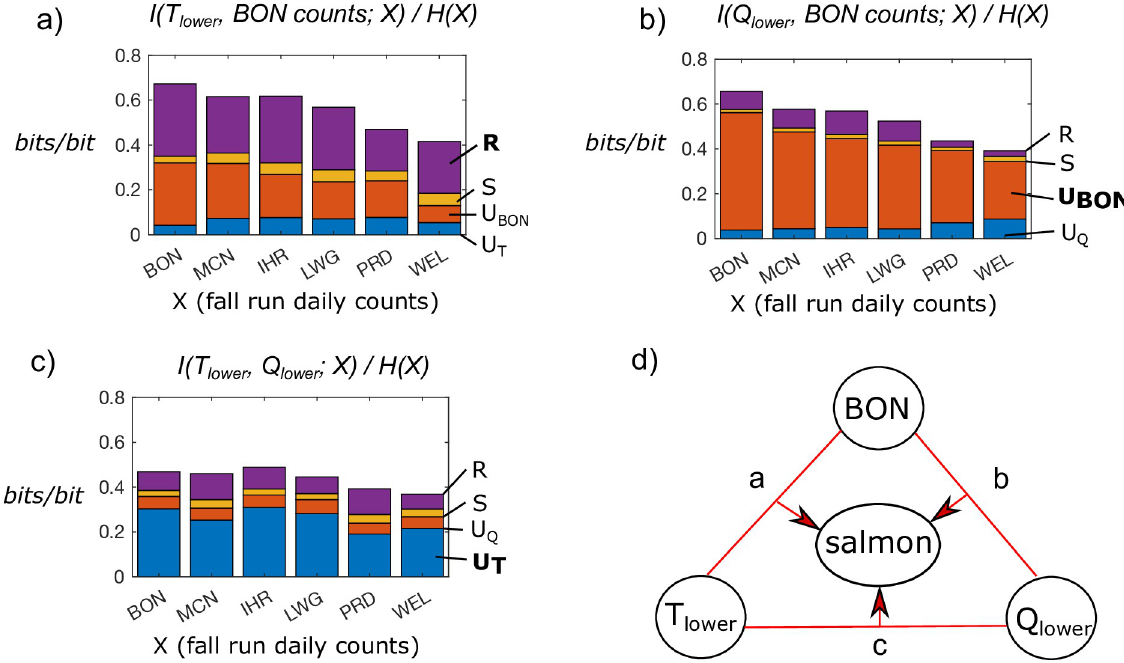
Fig 6. Total information (Eq 4), normalized by entropy of salmon counts, and information decomposition components (Eq 5) to counts at each dam, from combinations of two joint sources for fall run salmon counts. Bar heights indicate total information, while colors are proportions of unique, synergistic, or redundant information types. (a) Lower Columbia water temperature T information sources. (b) Lower Columbia flow rate Q lower and BON as lagged information sources. (c) T lower and Q lower as lagged information sources. Patterns of joint information are similar for spring run salmon, but some information from Q was found to be non-statistically significant.